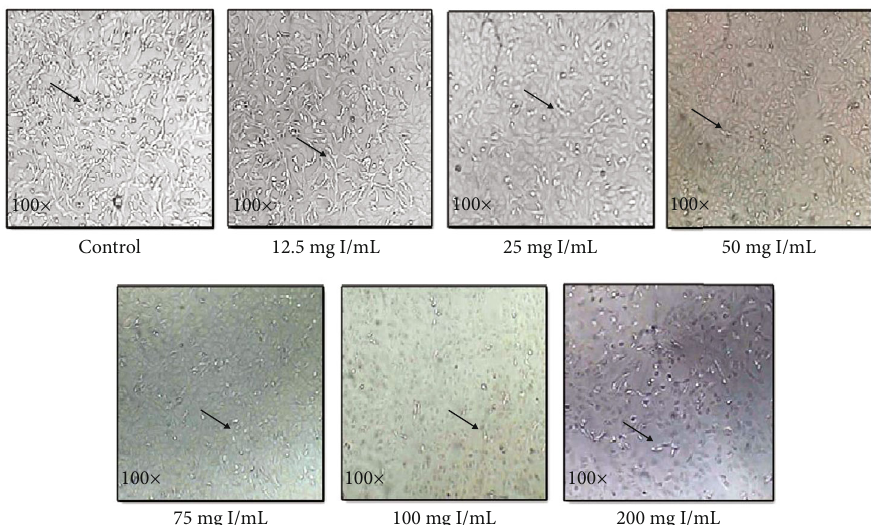
Figure 2: Vero cells under the microscope after subjecting to di ff erent doses of iohexol containing increasing concentration of iodine (I) ( n = 4 ). Magni fi cation 100x. The control group displays healthy, growing cells with elongated morphology (black arrows), whereas the cells incubated with iohexol show signs of rounding up.